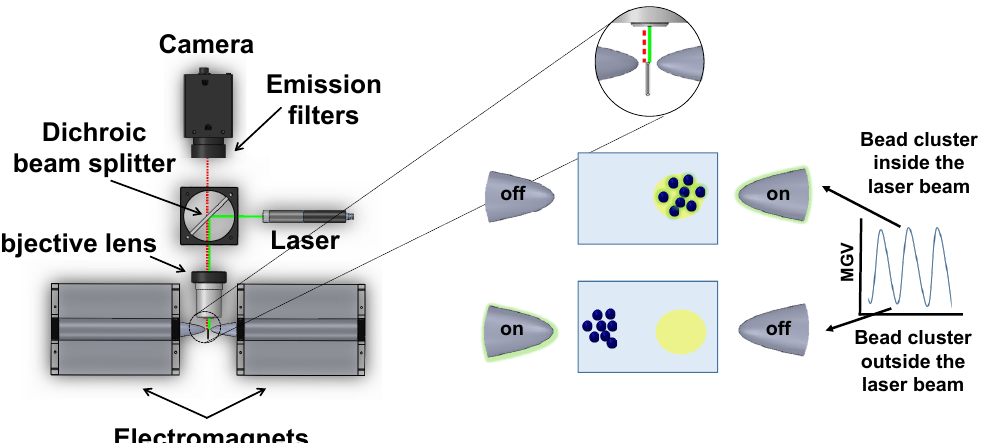
Figure A1. Schematic of laser beam system and data analysis.